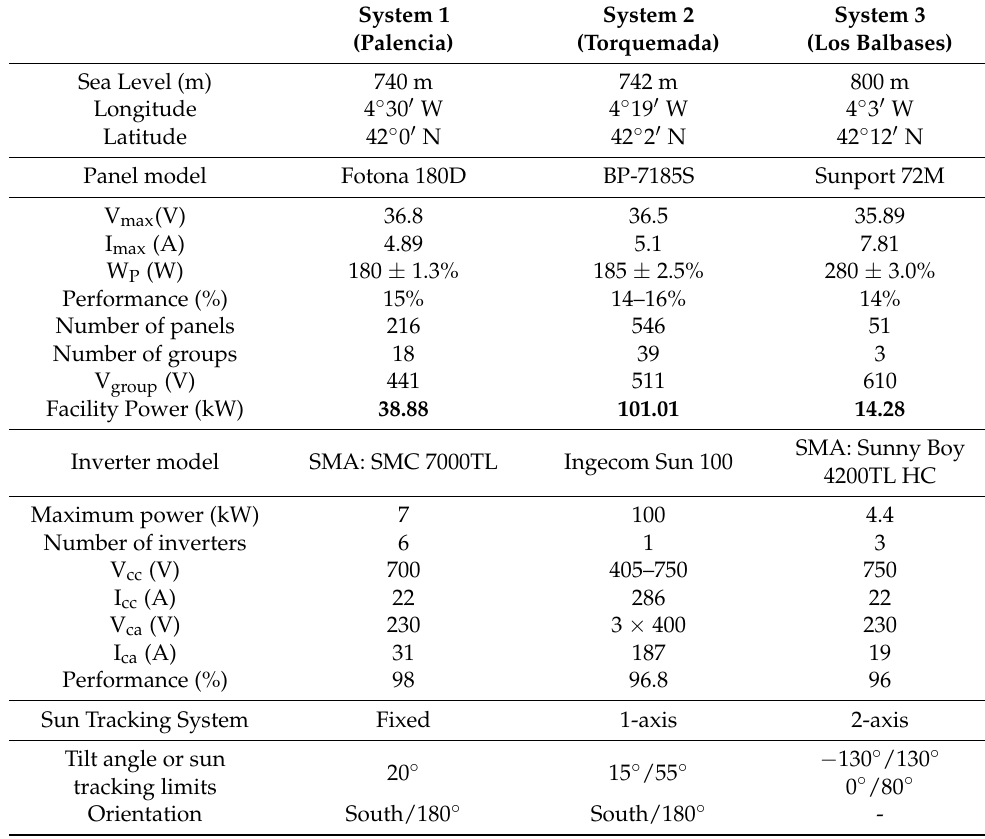
Table 2. Technical specifications of panels and inverters used in the PV facilities under study (System 1, System 2, and System